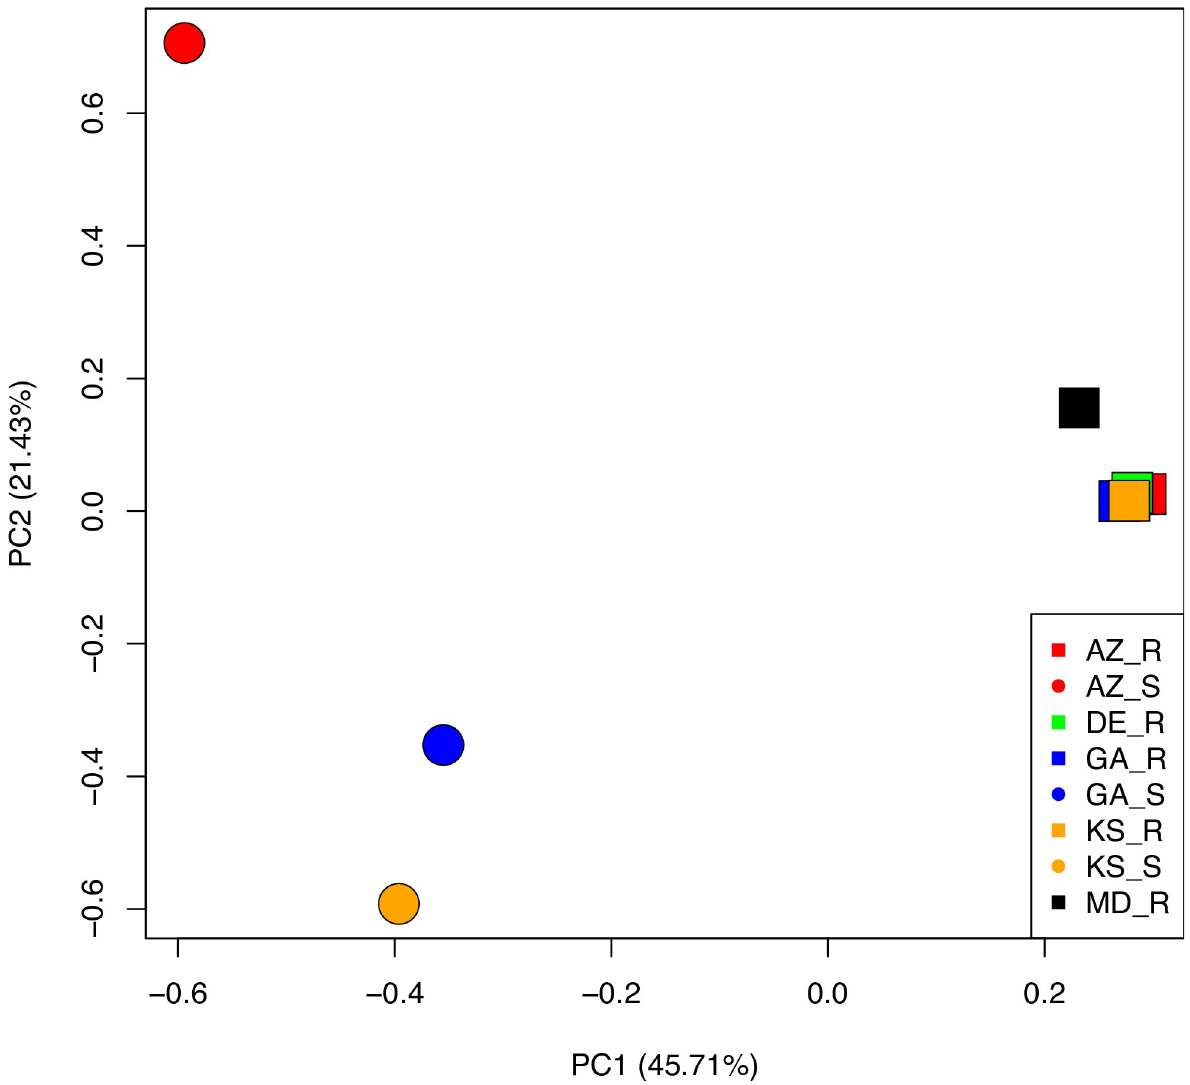
Fig 5. Principal component analysis of WGS reads from R and S plants. Principal component analysis of WGS reads from GR and GS plants from different locations indicating the level of similarity among EPSPS replicons. Note that the symbol for GA_R is nearly covered by that of KS_R.